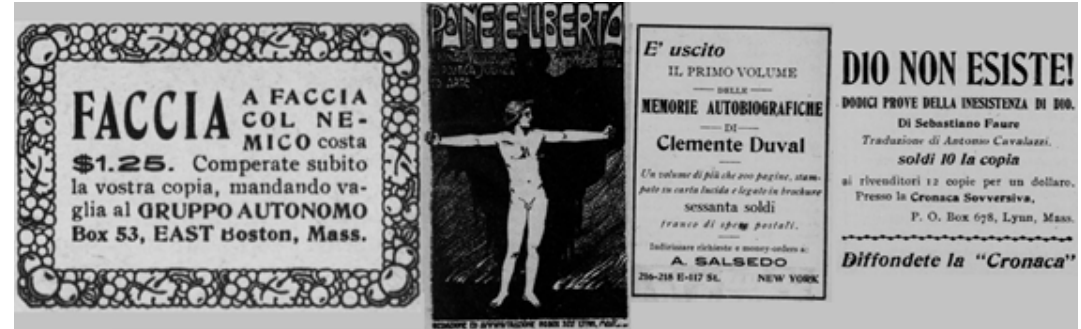
Advertisements featured in the Cronaca Sovversiva for a variety of projects, left to right: a booklet of ‘Faccia a Faccia Col Nemico’, the journal Pane e Liberta , Clemente Duval’s autobiography and a booklet of Sébastien Faure’s ‘Twelve Proofs of God’s